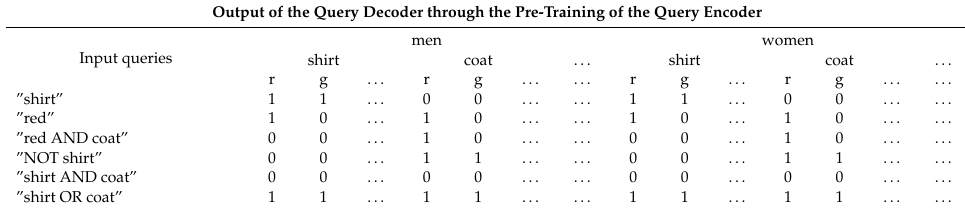
Table 6. Di ff erent user queries and the results obtained after the pre-training of the query encoder and